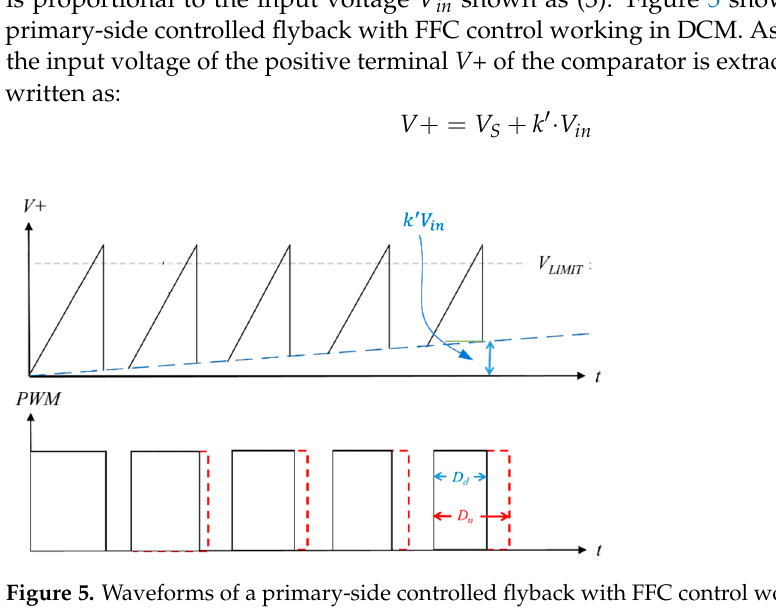
Figure 4. V-I curve of the traditional method and the proposed method.